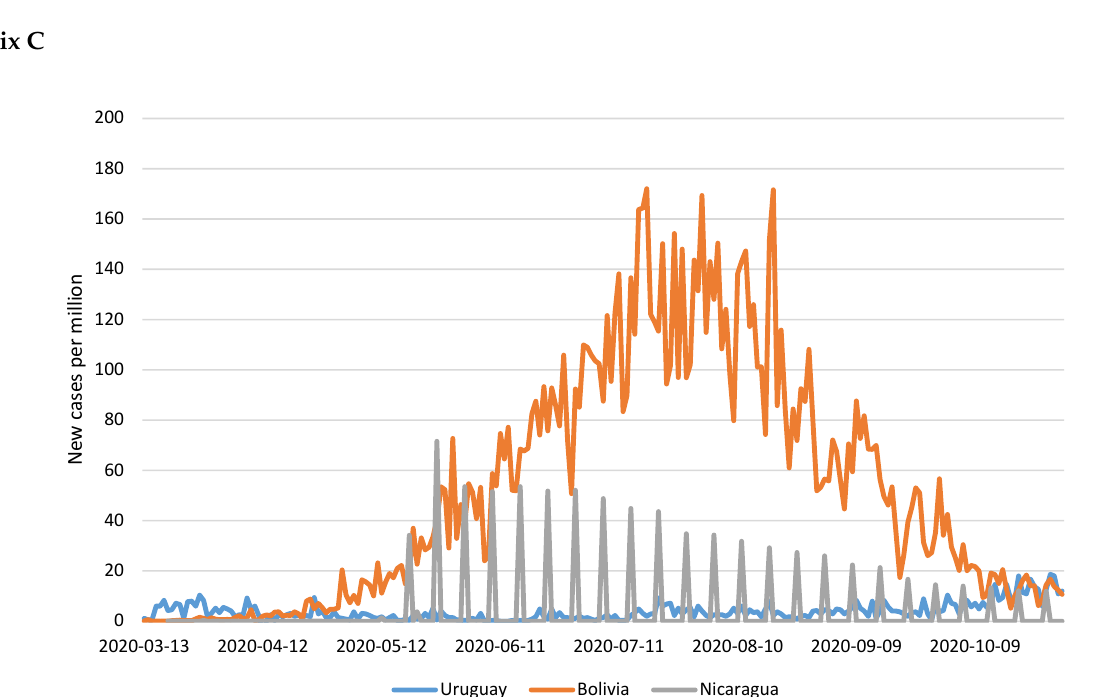
Figure A1. COVID-19 new cases per million inhabitants, Bolivia, Nicaragua, and Uruguay, March to December 2020.